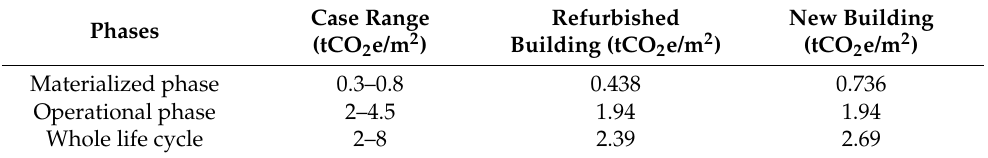
Figure 11. Comparison between existing cases and this project. Table 10. Whole life cycle carbon emission level of the refurbished building and new